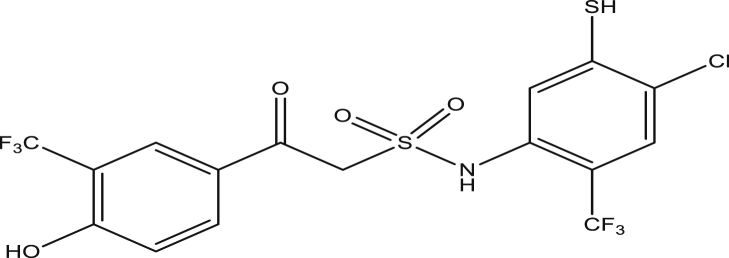
Compound 9g [N-(4-chloro-5-mercapto-2-(trifluoromethyl)phenyl)-2-(4-hydroxy-3-(trifluoromethyl)phenyl)-2-oxoethanesulfonamide (pEC500.4591197)].